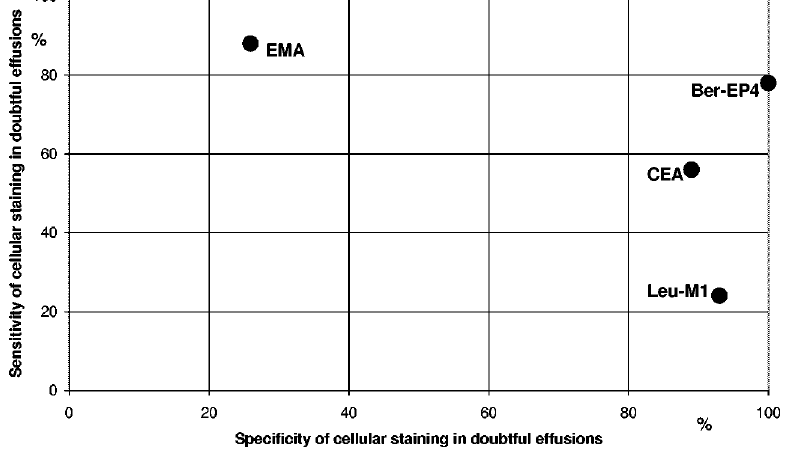
Fig. 1.Sensitivity and specificity ofcellular staining by four immunocytochemical markers in 65 equivocal effusions. Ber-EP4 marks asurface and cytoplasmic glycoprotein, EMA(epithelial membrane antigen) ahuman milk fat globulin, CEA (carcinoembryonic antigen) a heavily glycosilated cytoplasmic protein and Leu-M1 a cytoplasmic oligosaccharid.